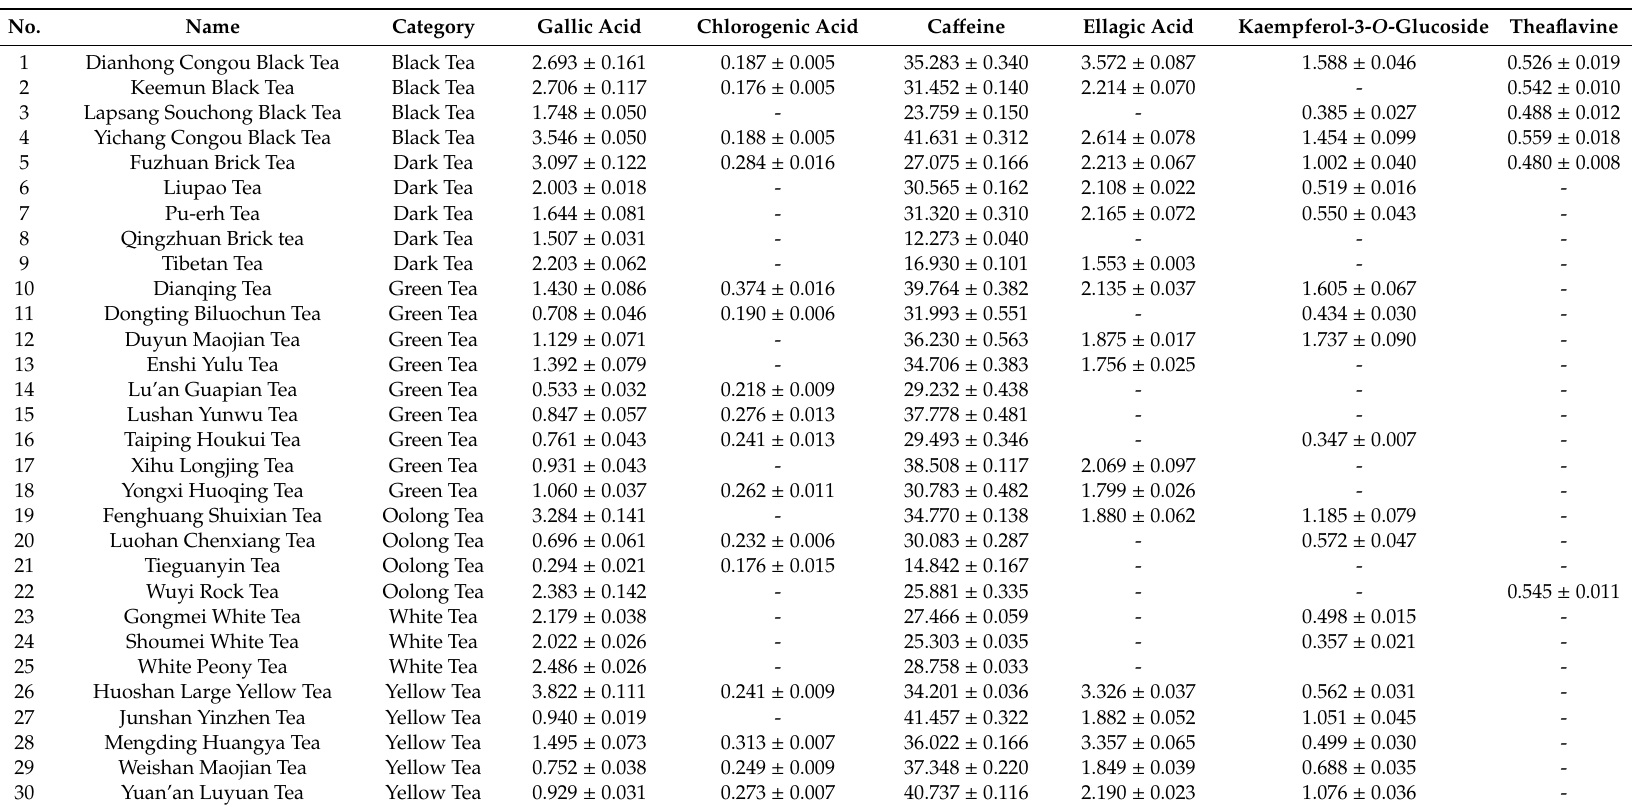
Table 8. The contents (mg / g DW) of other main phytochemicals besides catechins in 30 Chinese